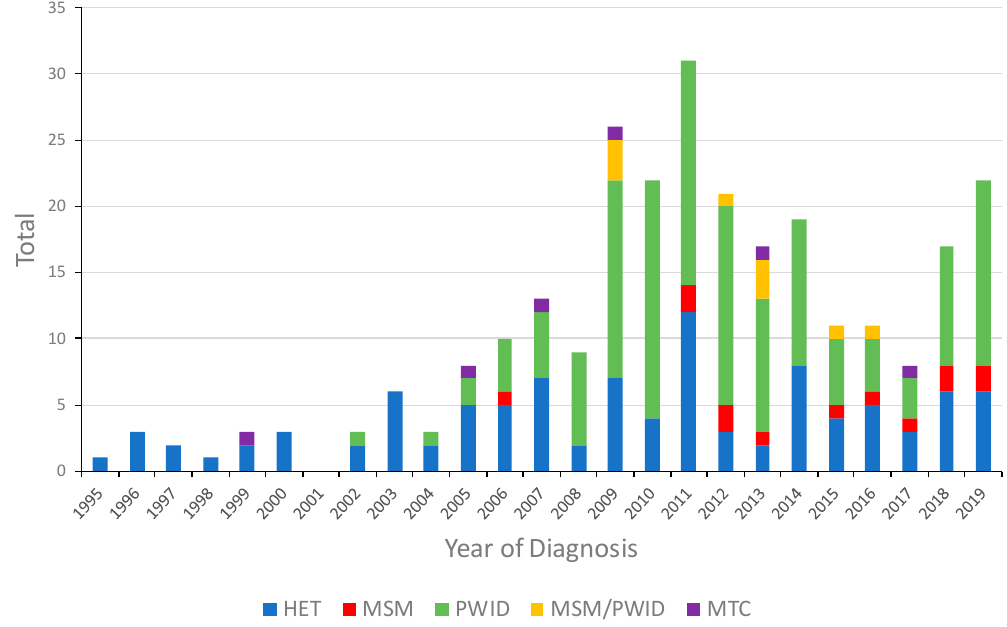
Figure 1. Noncumulative epidemiologic curve of HIV-1 CRF01_AE diagnoses in Bulgaria from 1995 to 2019 by transmission category. HET, heterosexual; MSM, men who have sex with men; PWID, persons who inject drugs; MSM/PWID (persons who reported both MSM and PWID); MTC, mother-to-child.